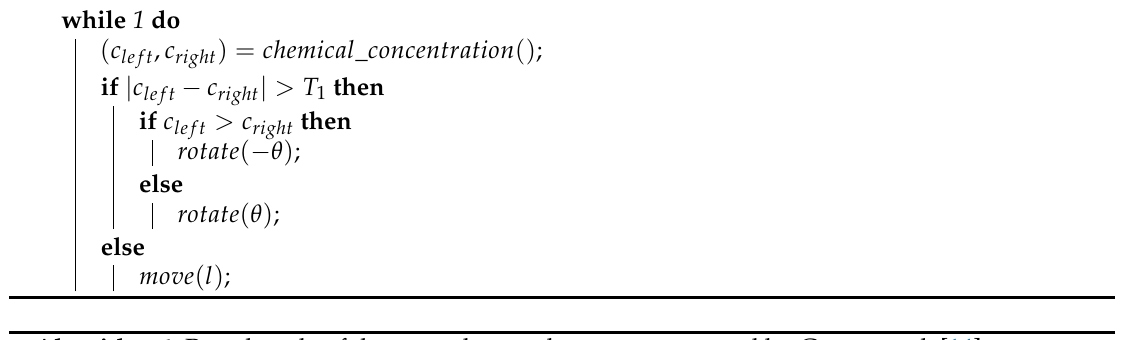
Algorithm 4: Pseudocode of the second control strategy proposed by Grasso et al.